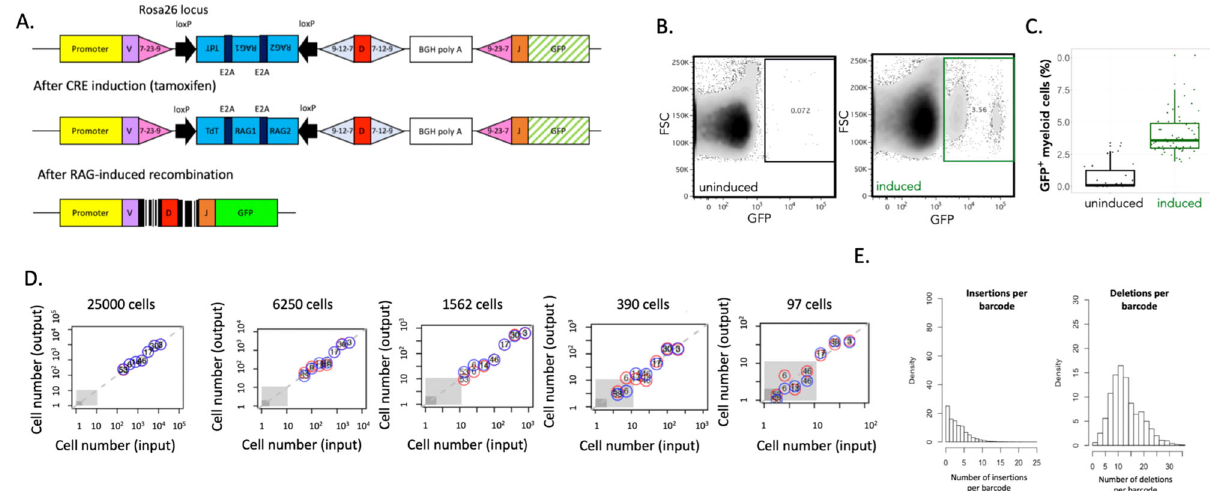
Fig.1|AquantitativeDRAGinsitubarcodingsystem.A DescriptionoftheDRAG cassette, as inserted into the Rosa 26 locus before and after induction. DRAG recombinationisinducedbyCreactivity,andresultingbarcodesequencesareused for lineage tracing. B Example of GFP expression in myeloid cells (CD11b + CD19 − CD3 − CD11c − ) in blood 6.5 months after tamoxifen (induced) or vehicle (control) administration. Within the GFP positive gate, a GFP mid and GFP high population is observed in myeloid cells. Both populations contain successfully recombined barcodes, and heterogeneity in GFP marker expression is likely due to the labeling of heterogeneous cell types with the pan myeloid marker cd11b (Supplementary Fig. 5A, B). In line with this, such heterogeneous GFP expression was not observed in non-myeloid cells. C Percentage of GFP + myeloid cells of total myeloid cells in tamoxifen-induced (green) and control (black) ( n =5 and n =3 male DRAG mice, respectively, all sampled over 13 months). Median and interquartile range with